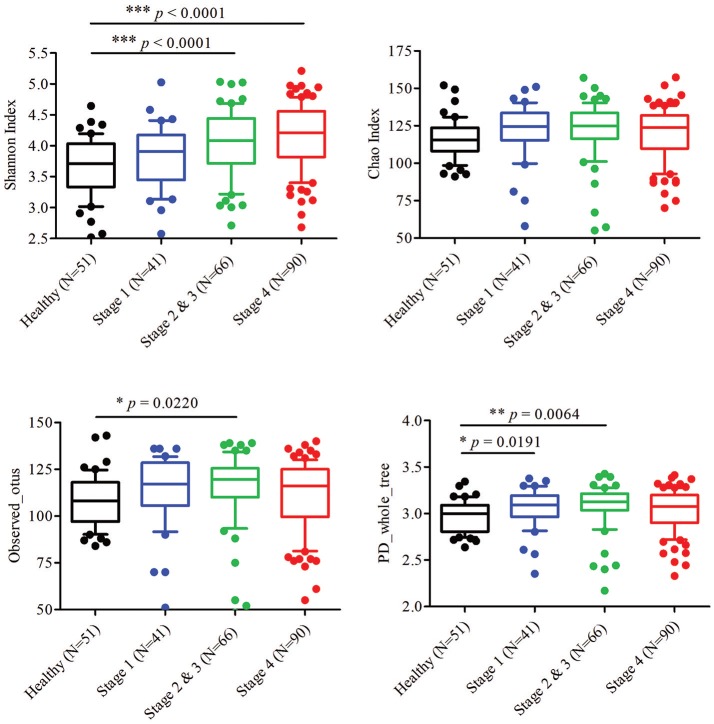
Diversity estimate calculations of bacterial taxa between healthy and OSCC patients. The Shannon index, Chao index, observed otus, and PD whole tree of the oral microbiome from healthy controls and OSCC patients. Horizontal lines represent mean values. p < 0.05 indicates statistical significance using a non-parametric Mann-Whitney U test.